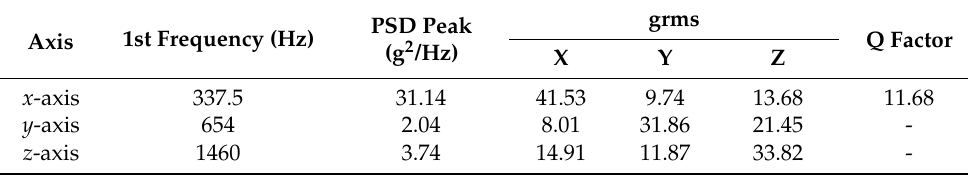
Figure 12. Component with minimum MoS in DRX. Table 7. Random vibration test results of each axis.